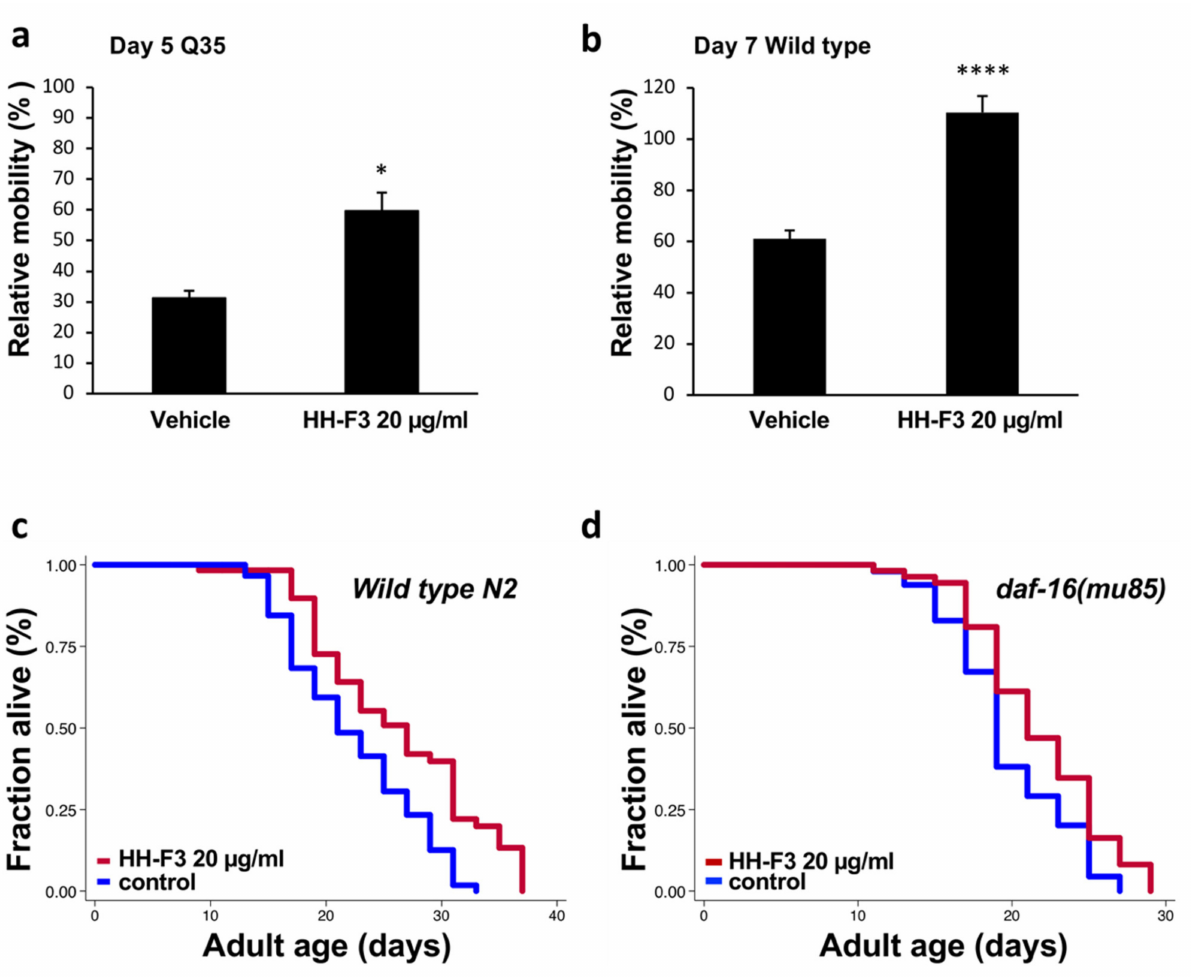
Figure 6. GP extract HH-F3 increased the health span and lifespan of C. elegans through a daf-16/FOXO-independent pathway. ( a ) Relative mobility of Day 5 Q35 animals treated with vehicle control or 20 µ g/mL HH-F3. Data are mean ± SEM as a percentage of the Day 1 vehicle control. ( b ) Relative mobility of Day 7 wild-type animals treated with vehicle control or 20 µ g/mL HH-F3. Data are mean ± SEM as a percentage of the Day 1 vehicle control. (* p < 0.05, **** p < 0.0001, Student’s t -test) ( c ) Lifespan analysis of wild-type N2 worms treated with or without 20 µ g/mL HH-F3. ( d ) Lifespan analysis of daf-16 mutants treated with or without 20 µ g/mL HH-F3. The detailed results of lifespan analysis are shown in